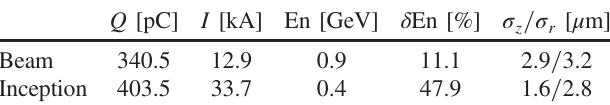
TABLE IV. Injected trailing (black) and inception (red) beams charge, Q ; current, I ; Root-Mean-Square (RMS), En, and energy spread, δ En; and beam longitudinal and transverse standard deviations, σ z and σ r ; from the simulation with the He profile given by Eq. (6), which is plotted in Fig. 2(a) in blue. Results extrapolated from all He released electron macroparticles in the simulation box at the end of the run (after they left the